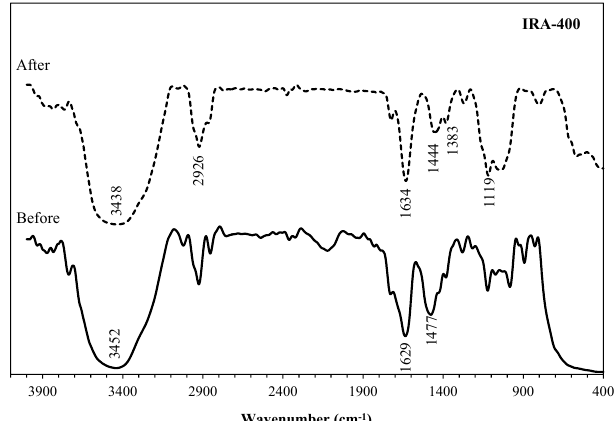
Fig. 7. FTIR spectra of the Amberlite IRA-400 adsorbent before and after Th(IV)